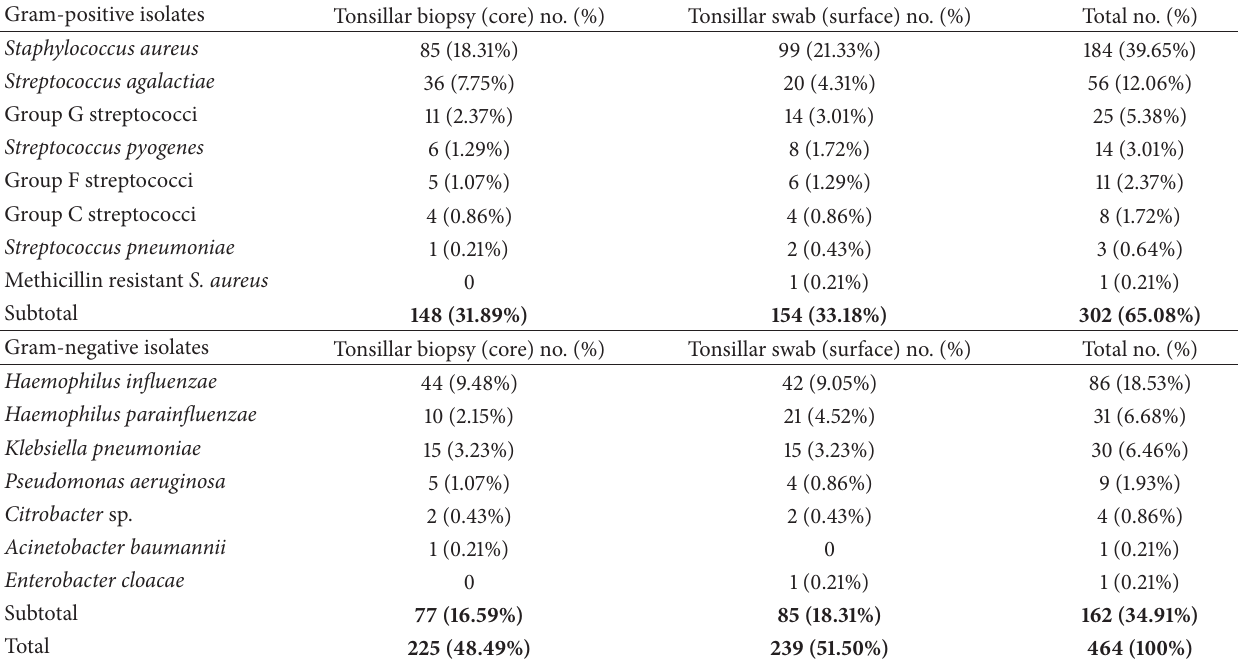
Table 2: Distribution of bacterial isolates among tonsillar specimens.